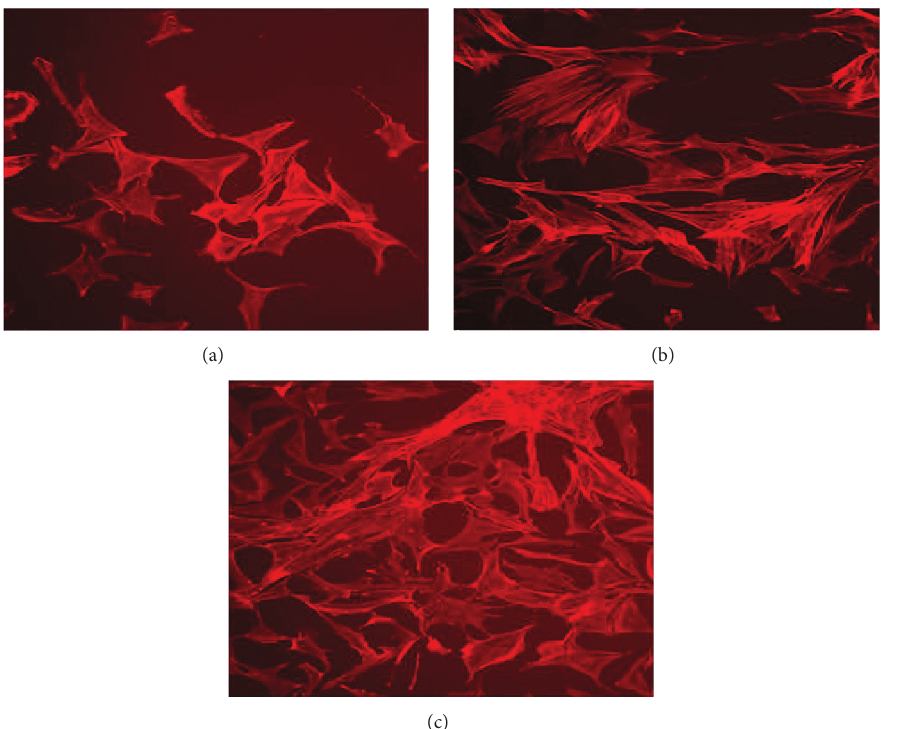
Figure 4: Effect of synovial fluid and TNF 𝛼 on cytoskeleton reorganization in fibroblast-like synovial cells. RA synovial fibroblasts were cultured for 7 days in the presence of TNF 𝛼 (25 ng/mL) (b), SF pool 1 (1:8 dilution in culture medium) (c), or medium alone (a). Actin cells were stained with Alexa Fluor